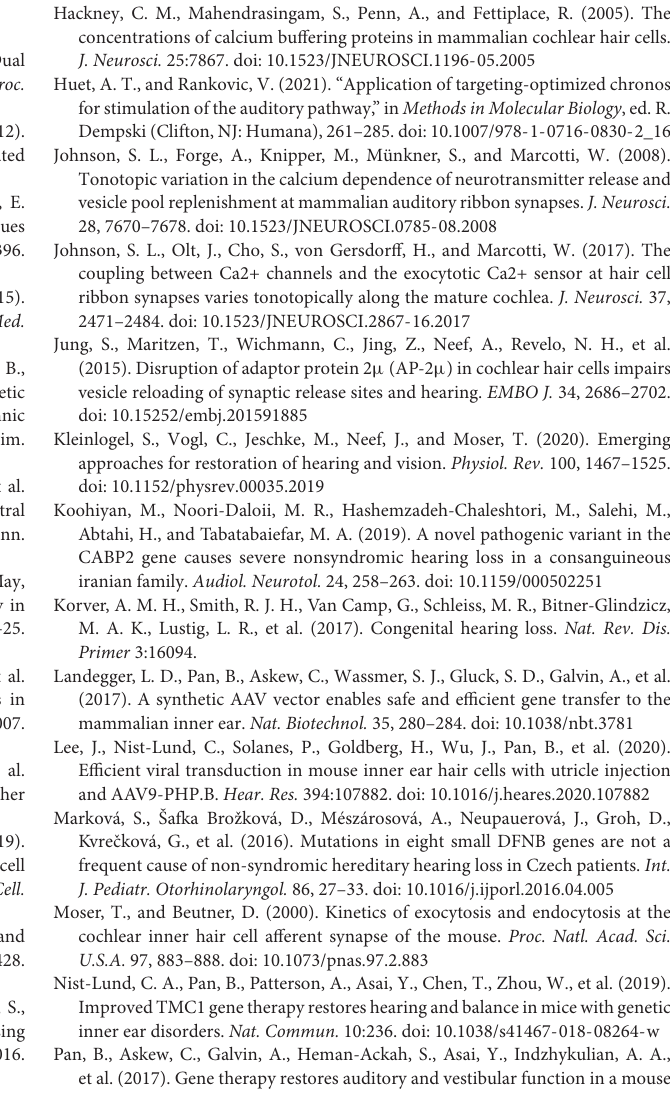
Supplementary Figure 3 | 20-Hz click ABR amplitudes including all PHP.eB-calcium-binding protein 2 ( Cabp2 )-injected animals. (A) Average responses to an 80-dB click stimulus presented at the repetition rate of 20 Hz. (B) Combined wave I-IV and (C–G) single ABR wave amplitudes to an 80-dB 20 Hz click stimulus of all animals. Note increased amplitudes from injected Cabp2 − / − ears as compared to control Cabp2 − / − animals for waves I, II, III, and IV (Tukey’s multicomparisons test, see Table 2 for p -values). ABR wave amplitudes in injected Cabp2 + / + animals were comparable to the non-injected Cabp2 + / + controls. (H) DPOAE thresholds in the individual injected and non-injected Cabp2 + / + animals. Asterisks denote p -values of less than 0.05. Supplementary Figure 4 | The effects of calcium-binding protein 2 (Cabp2) overexpression on the IHC calcium currents and morphology in wild-type animals. (A) Current-voltage relationship in IHCs of injected wild-type animals vs. non-injected controls. (B,C) Average absolute (B) and normalized (C) calcium current responses upon 500-ms depolarization steps to the peak calcium current potential in injected and non-injected wild-type IHCs. Overexpression of Cabp2 (or eGFP) results in partially reduced calcium current amplitudes. (D) Representative example of PHPeB- Cabp2 injected cochlea of a wild-type animal immunolabeled for eGFP and parvalbumin alpha. No significant loss of hair cells was observed upon viral injection and overexpression of Cabp2 and